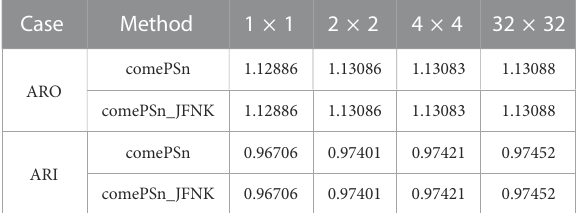
TABLE 1 Results of k-eigenvalues on different mesh sizes per pin for 2-D KAIST-3A benchmark problems.